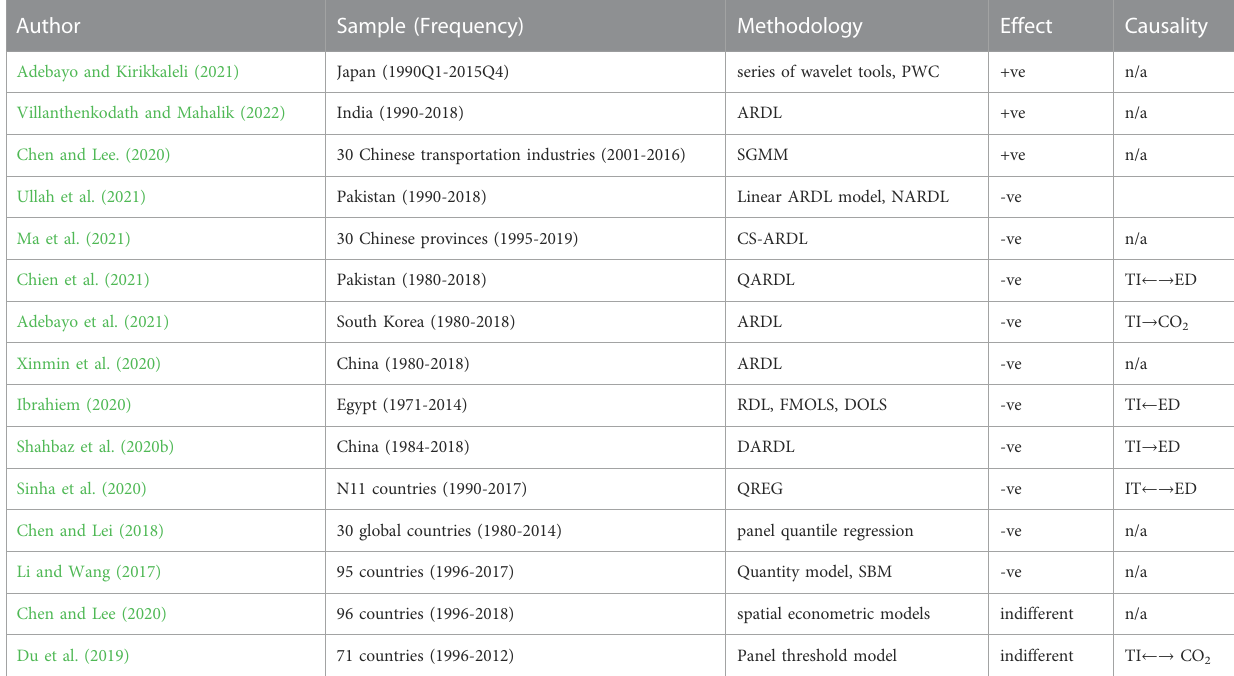
TABLE 4 Summary literature survey: TI-led